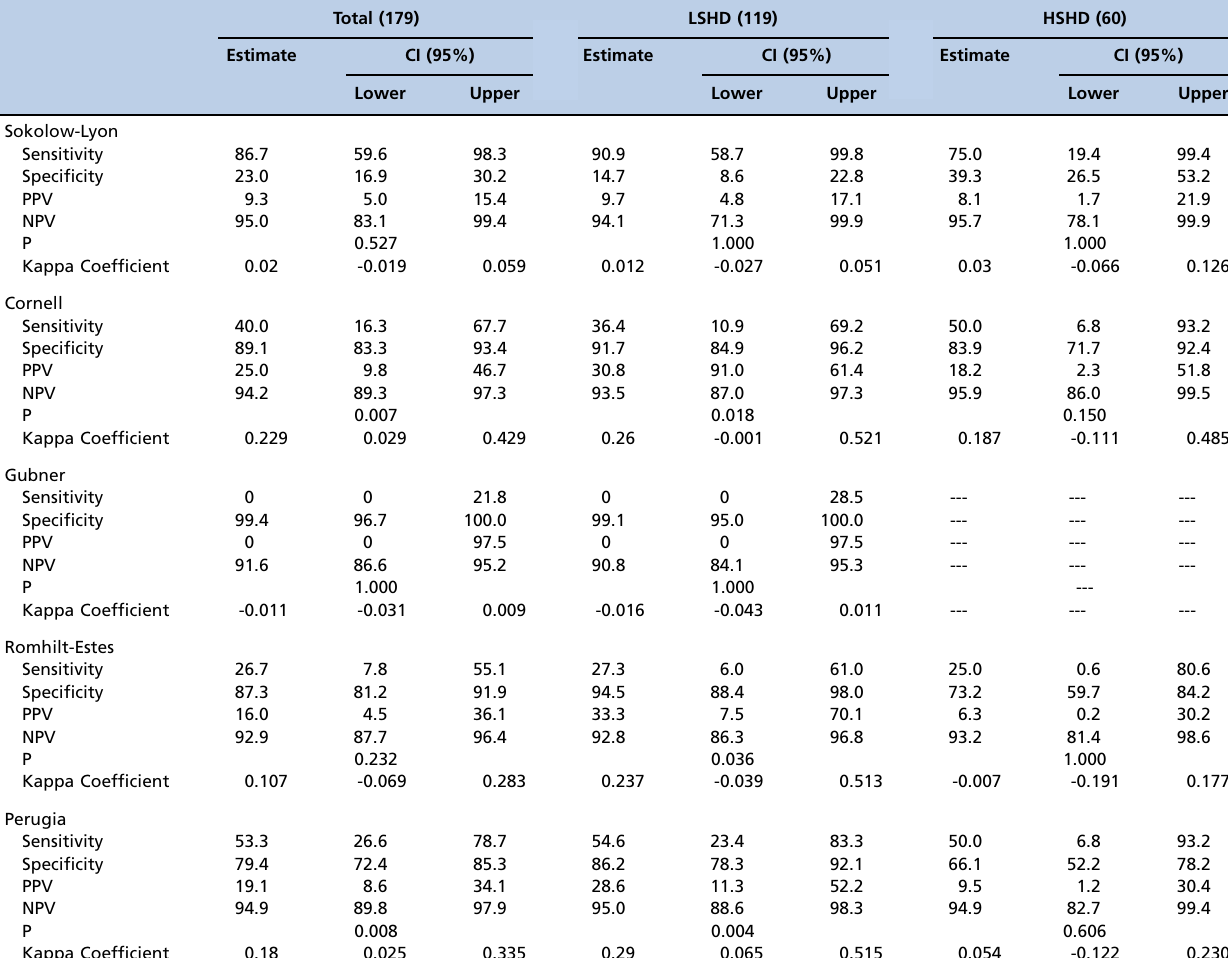
Table 4 - LVDDI and/or Septum and/or PWT x Electrocardiogram